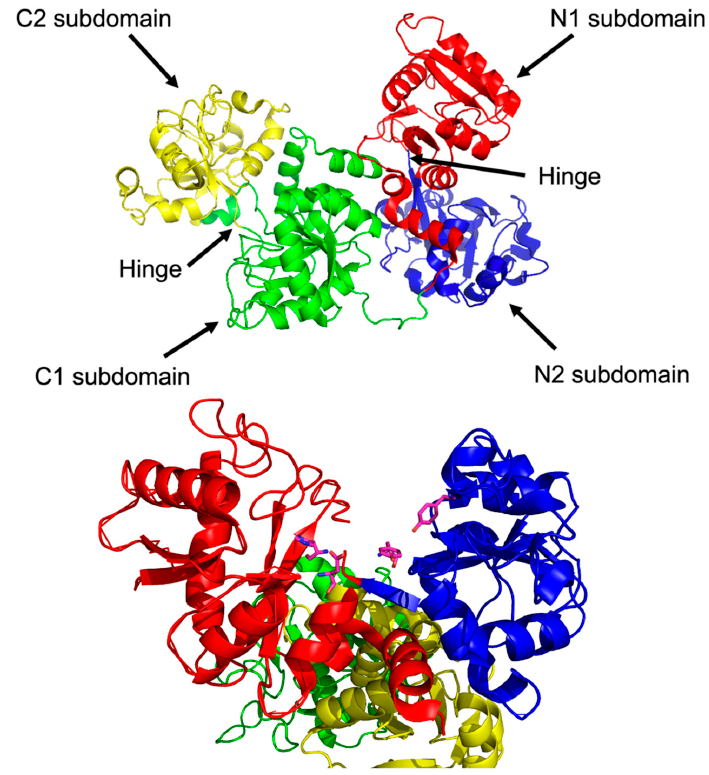
Figure 3. The structure of glycosylated apo-sTf divided into its lobes and subdomains (Top). A close up of the metal binding residues of the N-terminal domain (Bottom). PDB code: 2HAV. N-lobe has more flexibility and could contribute to the difference in Fe(III) affinity and binding and release kinetics. By superimposing their apo-sTf (Fe(III) free) structure with pig diferric sTf (Fe 2 -sTf), Wally et al., found that the N1 and C1 subdomains align very well, while the C2 and N2 subdomains do not, which indicates that the N2 and C2 subdomains are responsible for opening and closing the lobes to capture and release the iron (Figure 4). The apo form is categorized by an open-conformation and the equilibrium between an open and closed-conformation but with the closed-conformation existing